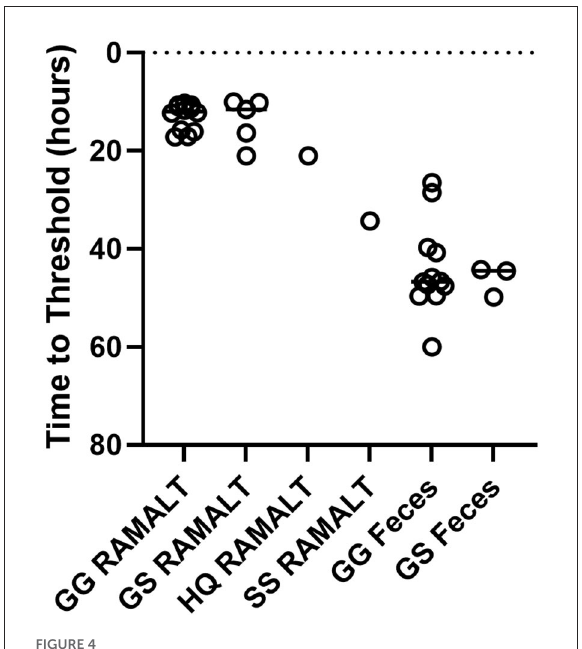
FIGURE4 Genotype variation and Ct values. RT-QuIC testing of RAMALT and feces for CWD-infected white-tailed deer with different genotypes. No significant difference between 96 GG ( n = 12) and 96 GS ( n = 5 RAMALT and 3 feces) in time to threshold for RAMALT or feces was found. Not enough data were present to statistically analyze other